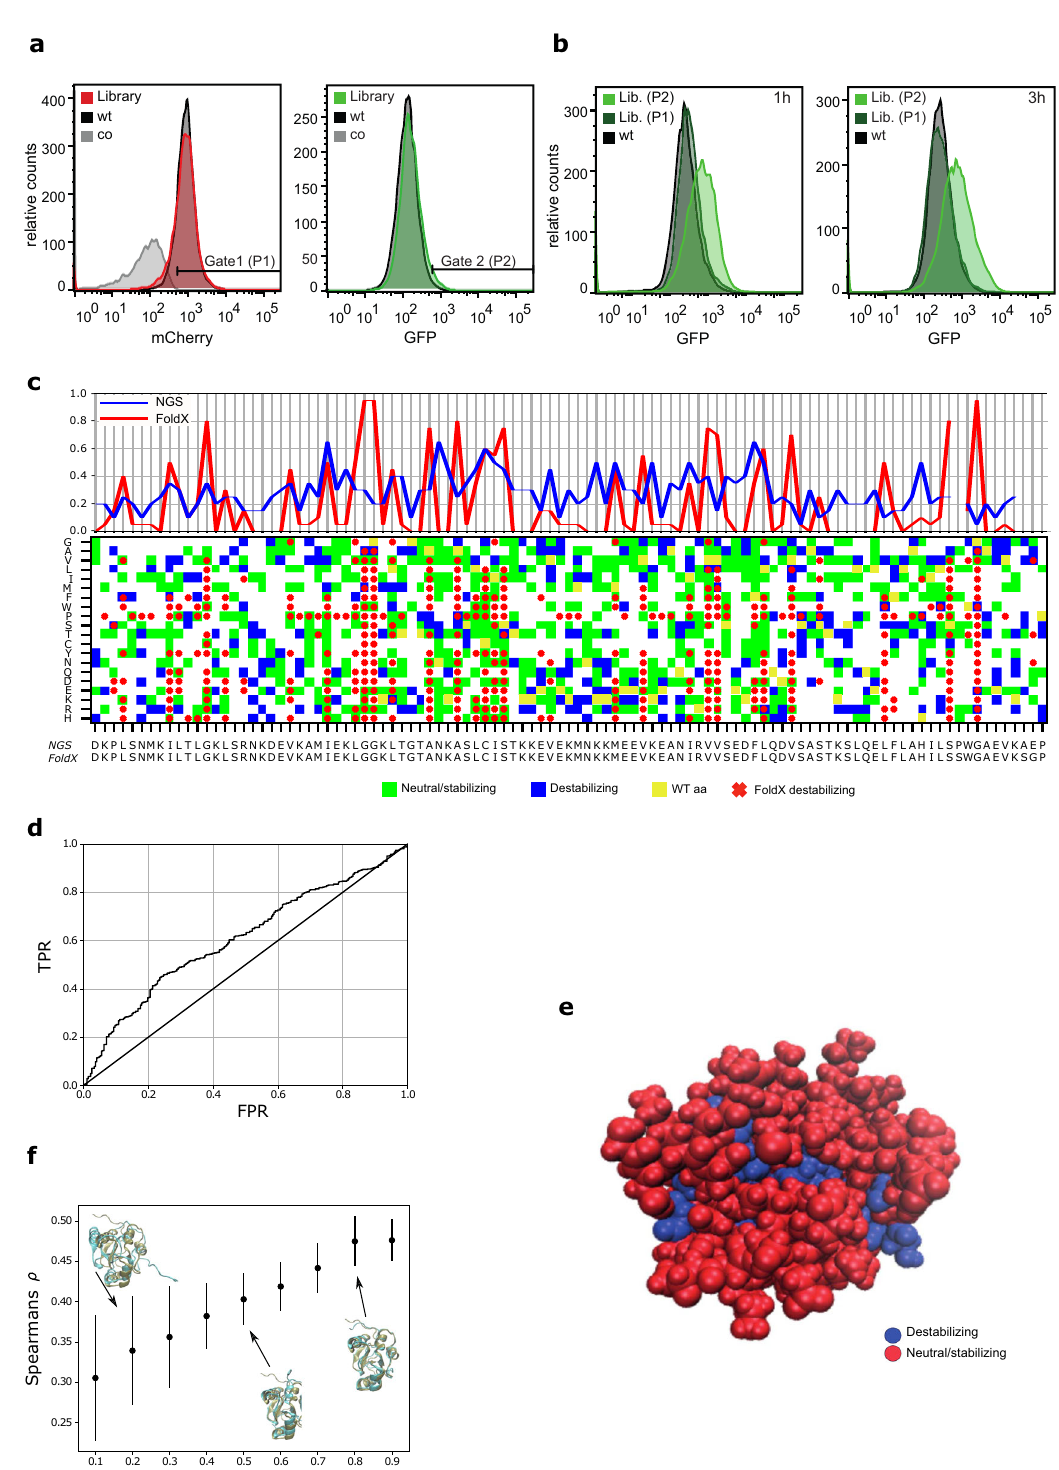
(Fig. 6a). Translation levels of the remaining 14 variants, of which 13 were predicted to misfold, were detected by a mCherry signal, but with either no translation level detected by Western blot, or with Western blot signals distinctly lower than what would be expected based on the mCherry signal. This suggests that these variants were translated correctly but possibly degraded by pro- teases in the cell before detection by Western blot. Moreover, lower GFP signals in cells expressing variants with low or no